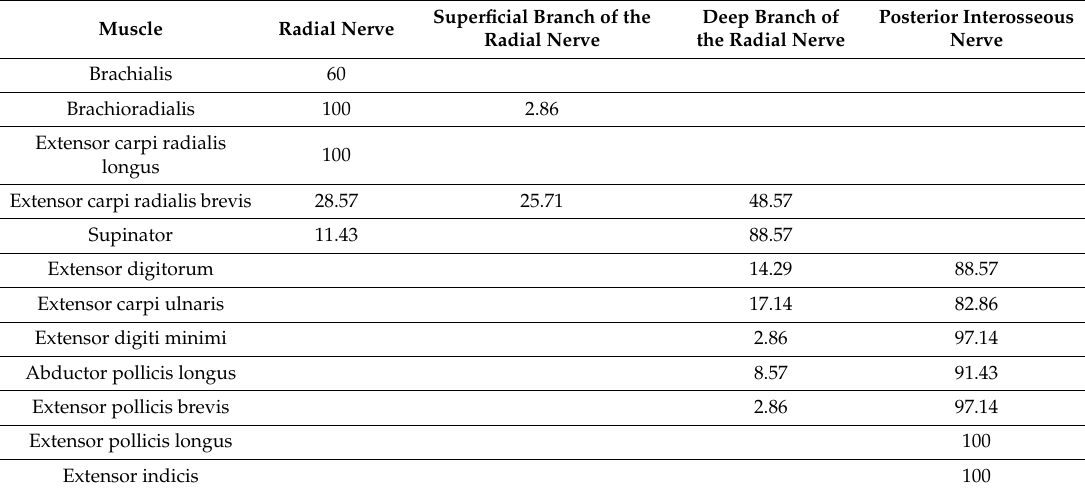
Table 3. Percentage distribution of each muscle among the branches of the radial nerve (e.g., muscular territories). Note: percentages for the brachioradialis (BR), the extensor carpi radialis brevis (ECRB) and the extensor digitorum (ED) sum to greater than 100% as certain specimens had dual innervation to these